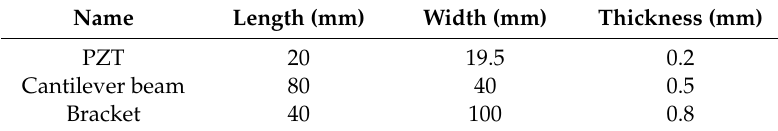
Table 1. Main dimensions of each component.